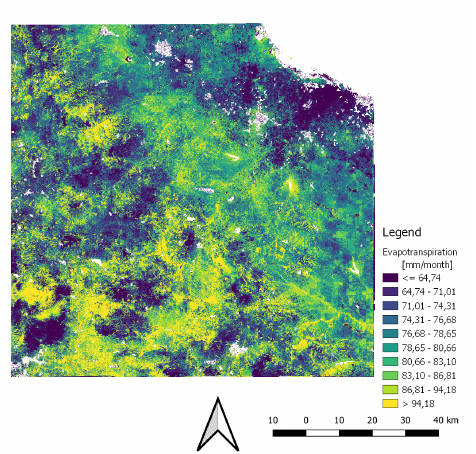
Figure 8. Evapotranspiration maps for Apulia area in March 2019.